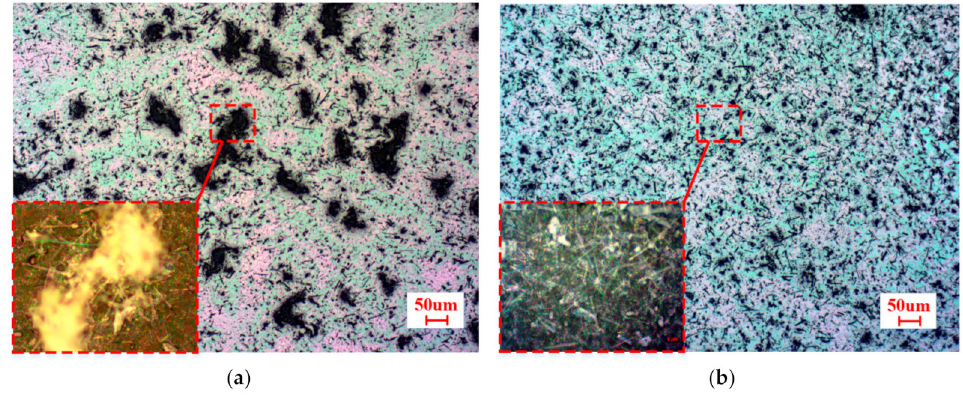
Figure 2. The diamond nanoparticle (DN) / silicon carbide whisker (SCW) / polyimide (PI) composite films prepared by ( a ) direct mixture process and ( b ) the pre-dispersion